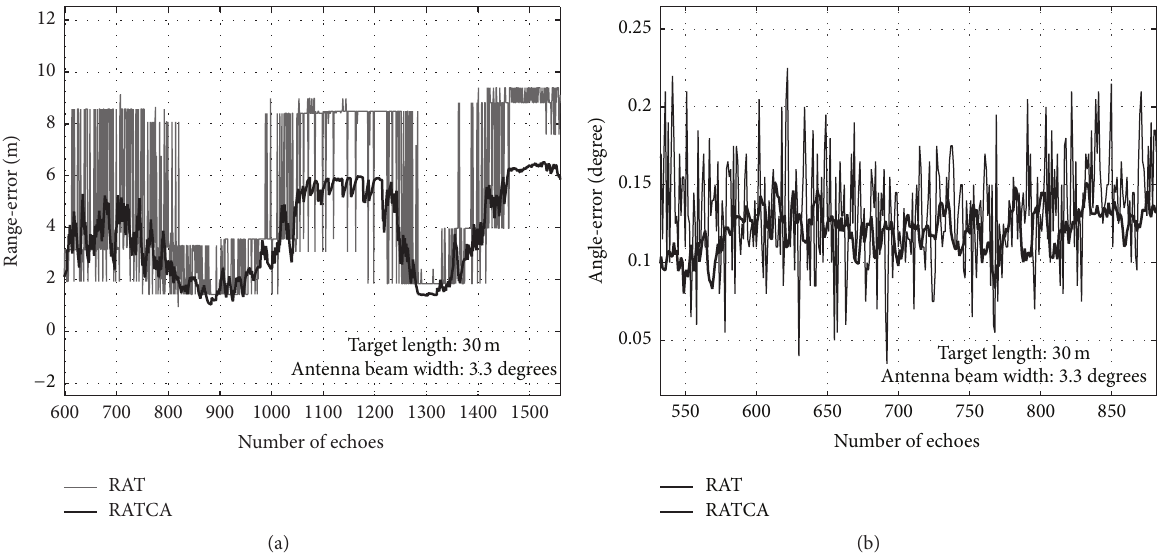
Figure 12: Comparisons of tracking performances between RAT and RATCA when radar is performing normally. (a) Range-error. (b)